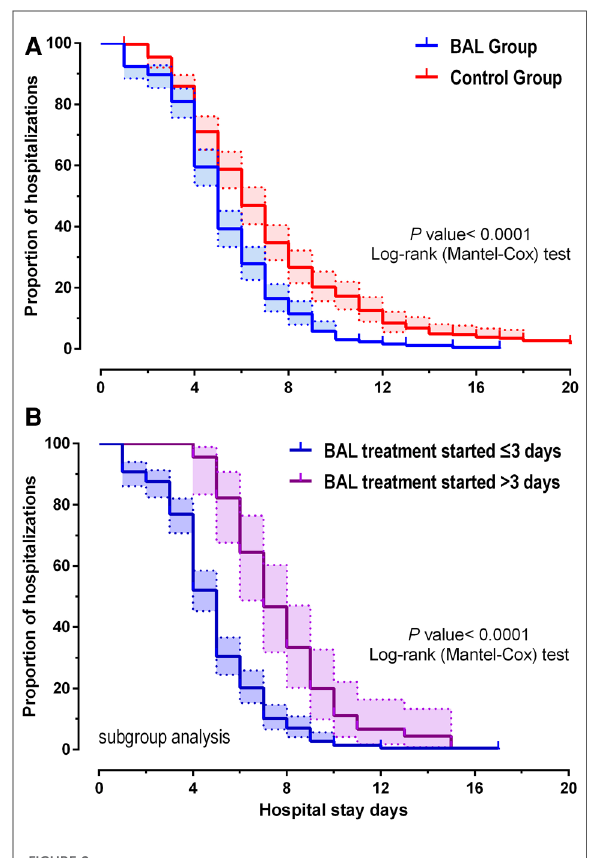
FIGURE 2 Kaplan-Meier plotter showing the discharge time for MMP patients ( A ). ( B ) shows the difference in length of stay between days 3 and 3 when the lavage was